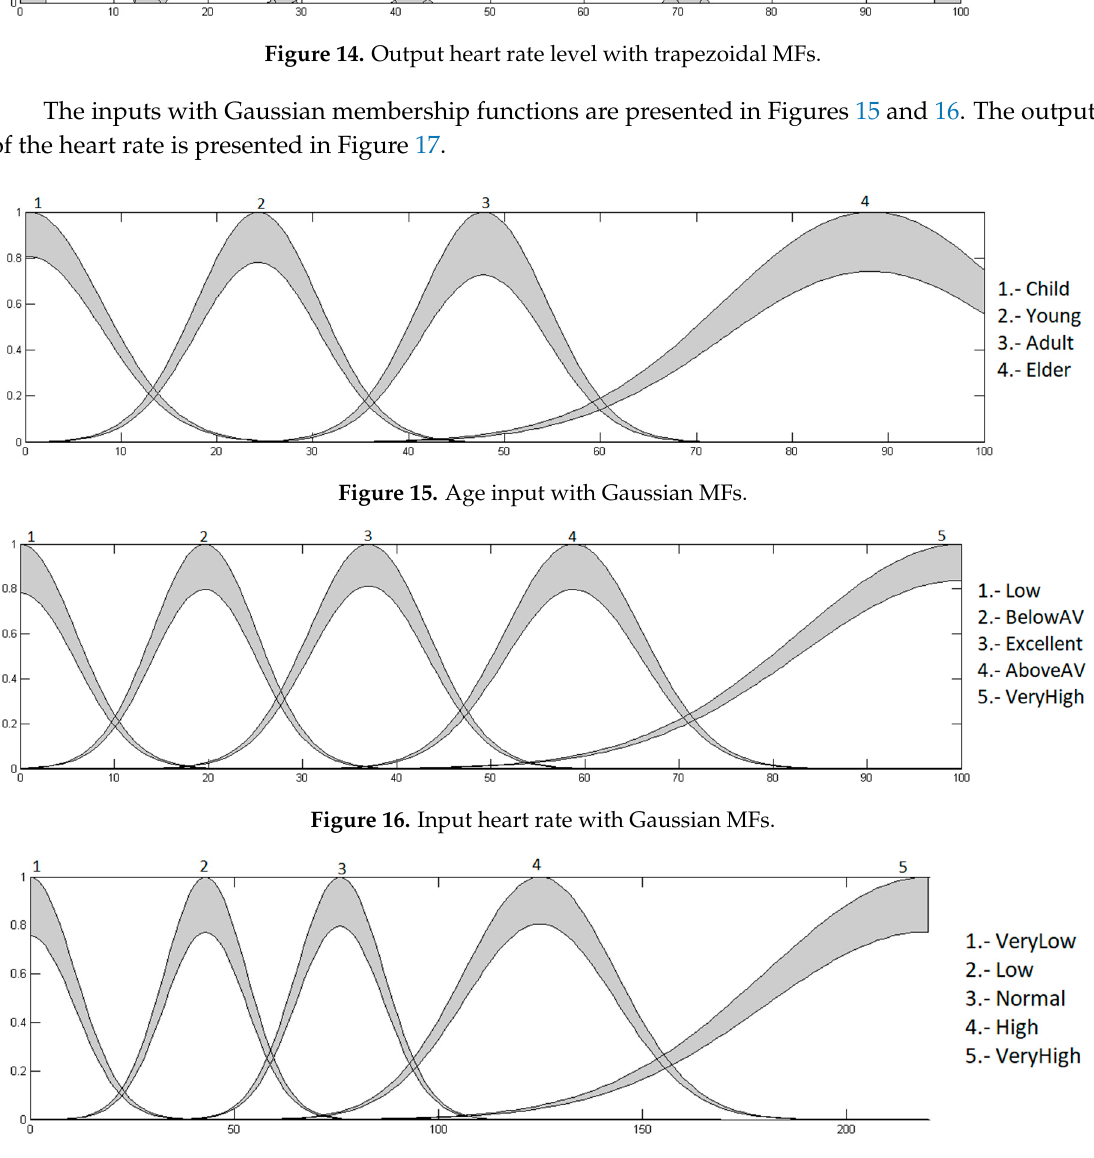
Figure 17. Output heart rate level with Gaussian MFs.